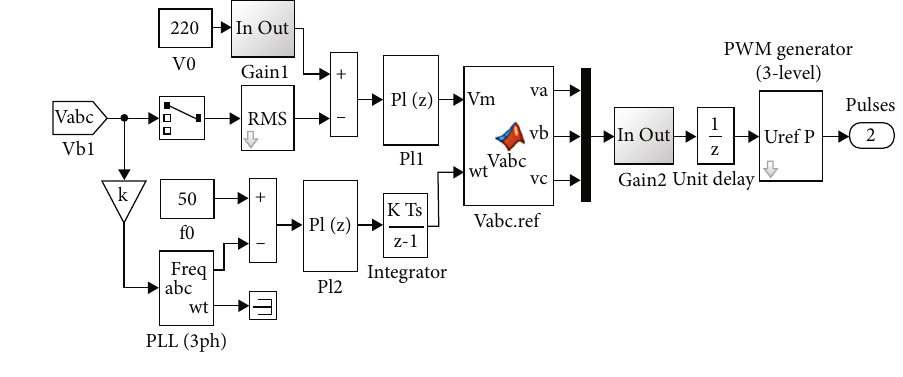
Figure 3: VSC control.